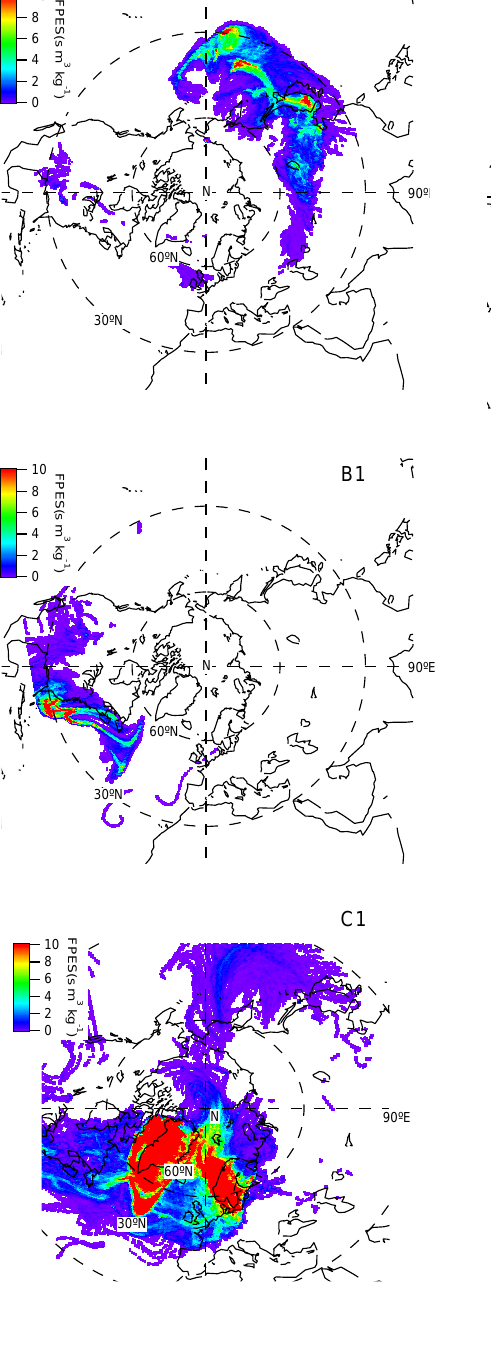
than 80 % of the grid-integrated total FPES. For the rest of the cases when R BG contributes less than 80 %, the air mass origin is then classified according to the relative contribu- tions of R AS , R EU and R NA . The air mass will be classi- fied as the specified source region if the relative contribution of any corresponding source region is greater than 60 % of